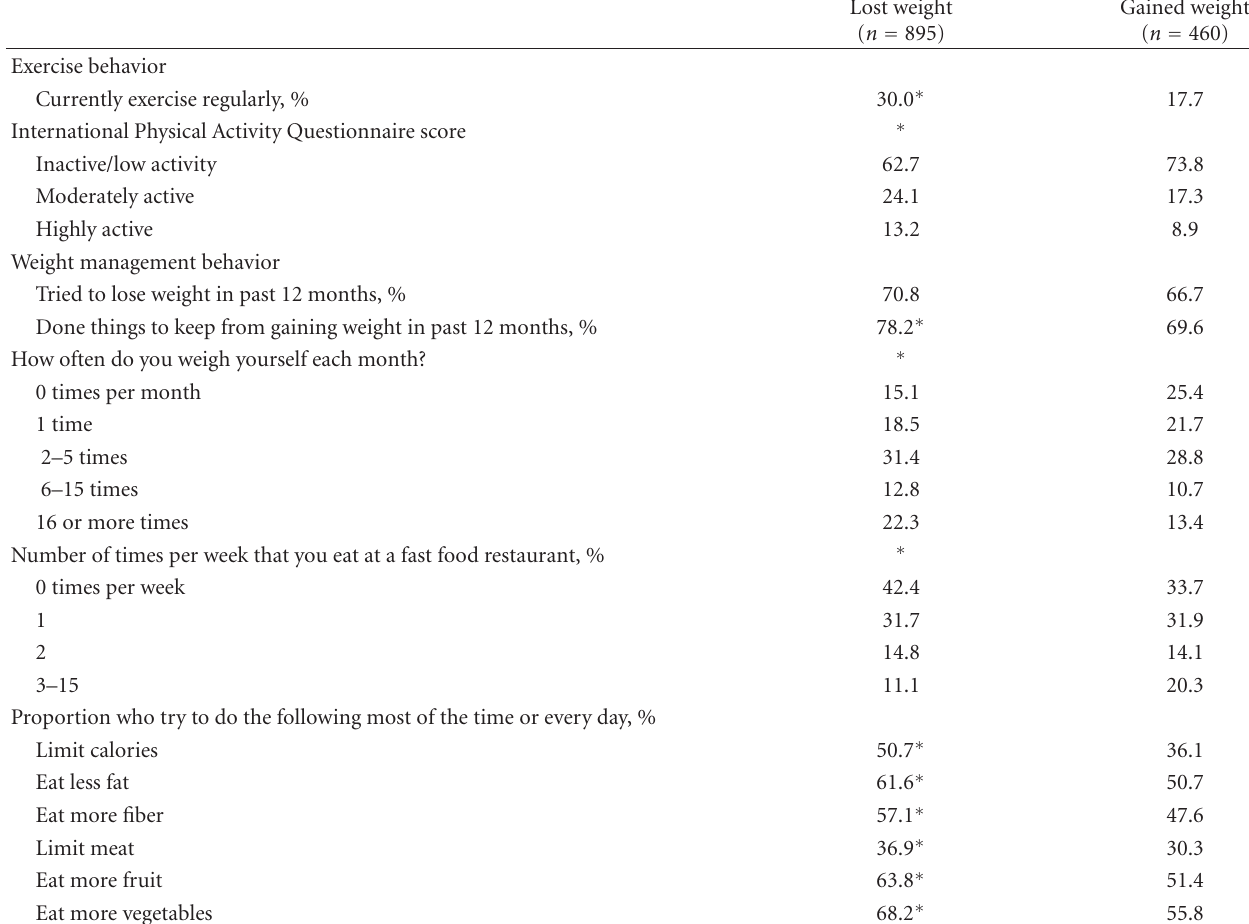
Table 2: Exercise and weight management behaviors among respondents with type 2 diabetes who reported gaining or losing weight in the past year.